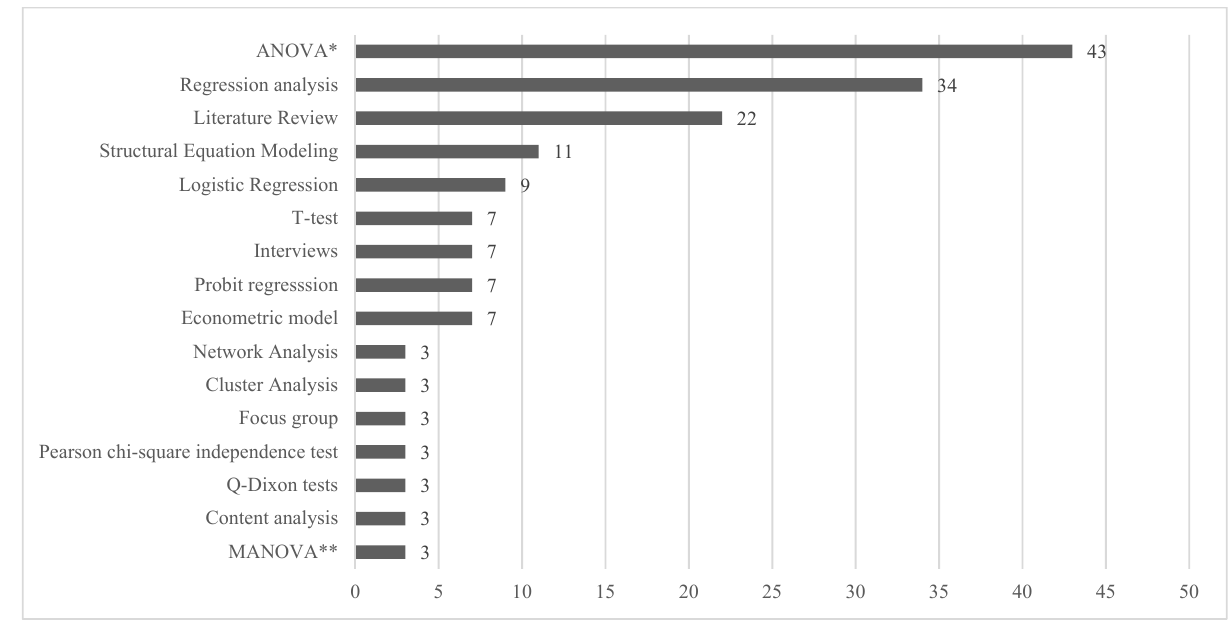
Figure 5. Adopted methodologies and analysis approach. * ANOVA: Analysis of Variance; ** MANOVA: Multivariate Analysis of Variance.